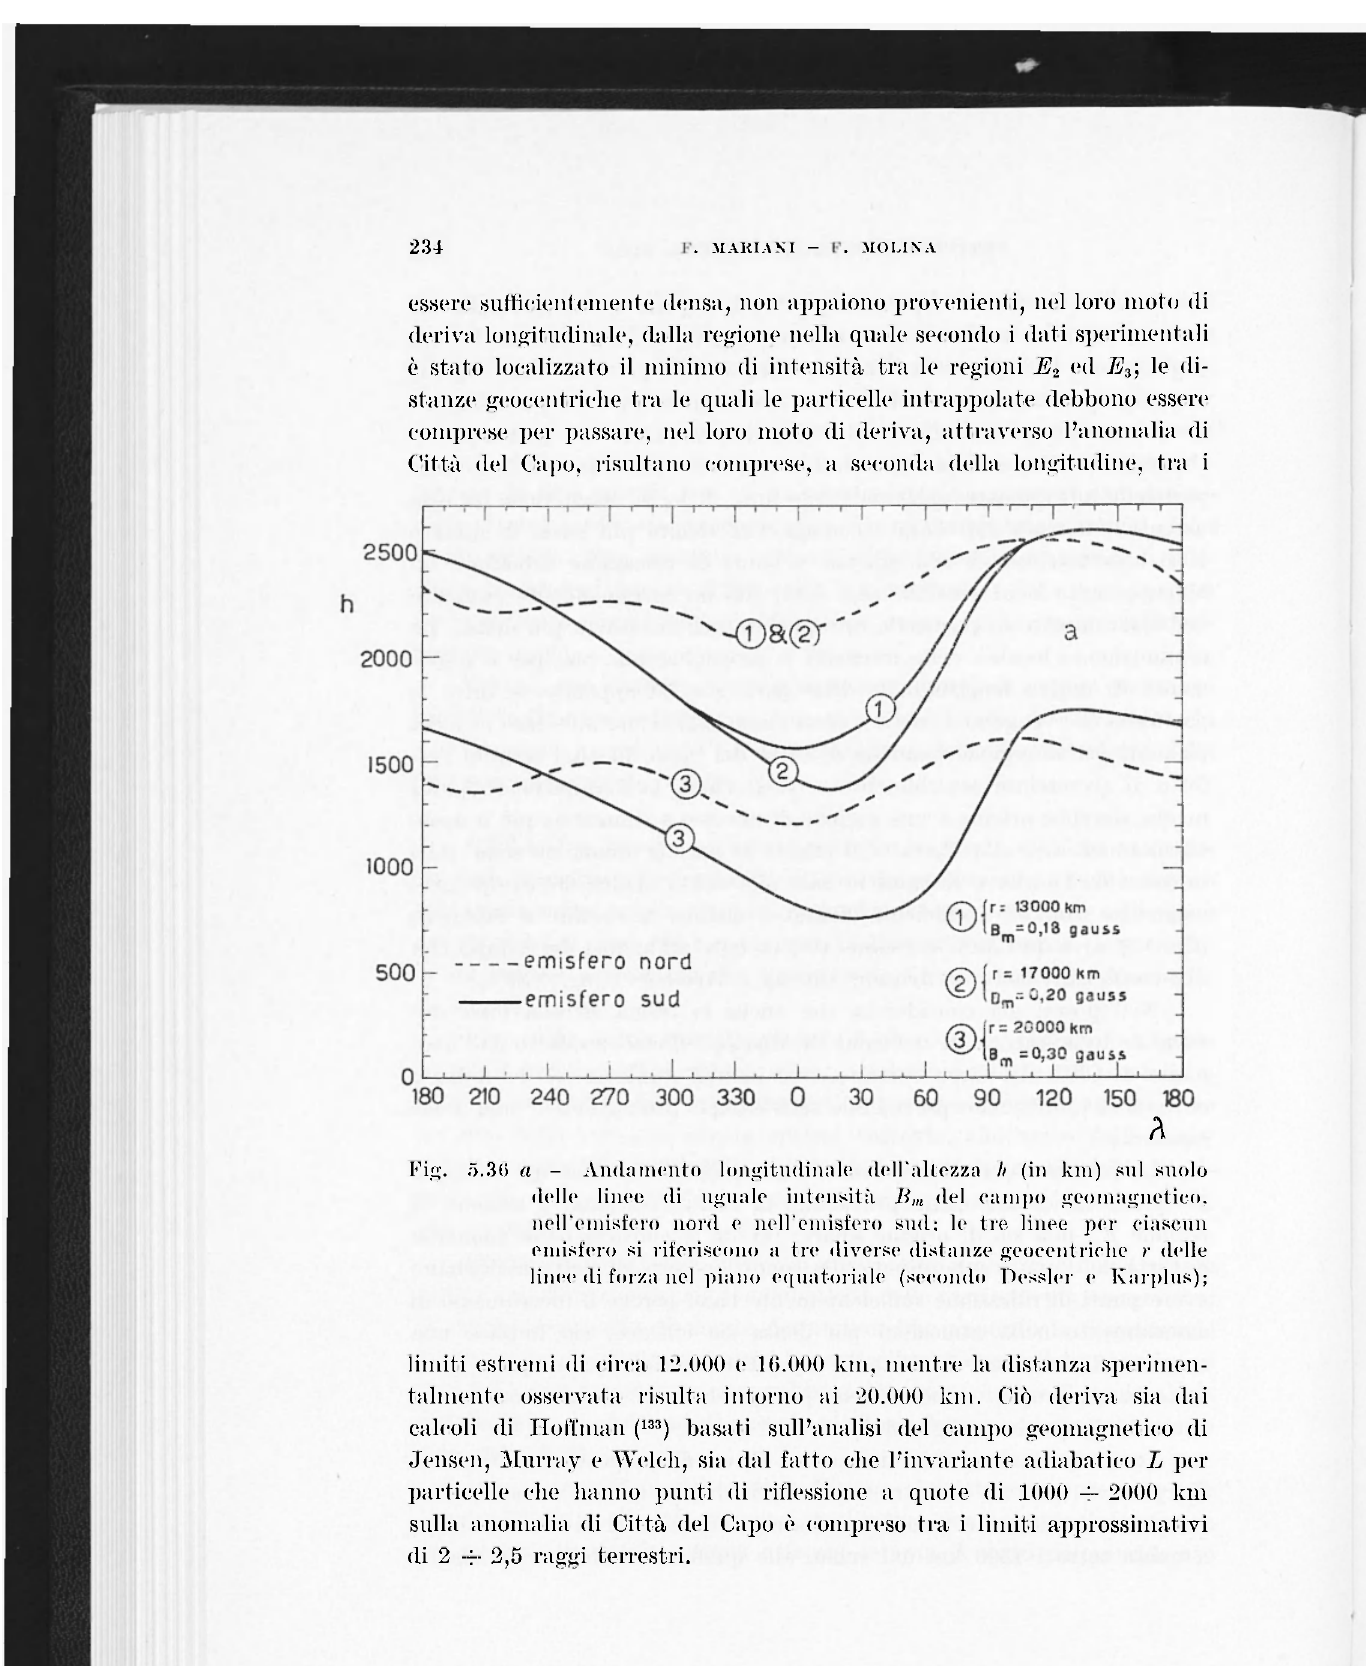
limiti estremi di circa 12.000 e 10.000 km, mentre la distanza